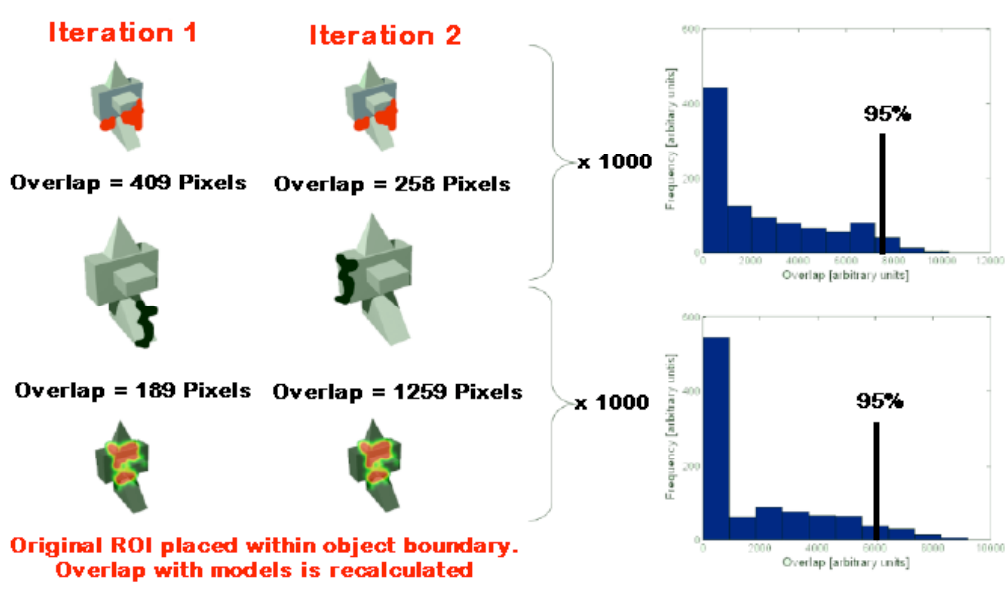
Figure 6 – An example of two of the one thousand iterations performed to build up the distribution of the overlap expected had ROI placement in the recorded data been a random process. The right hand side histograms show the results of the Monte Carlo procedure for the saliency data (top) and the 3-D Segmentation model data (bottom).